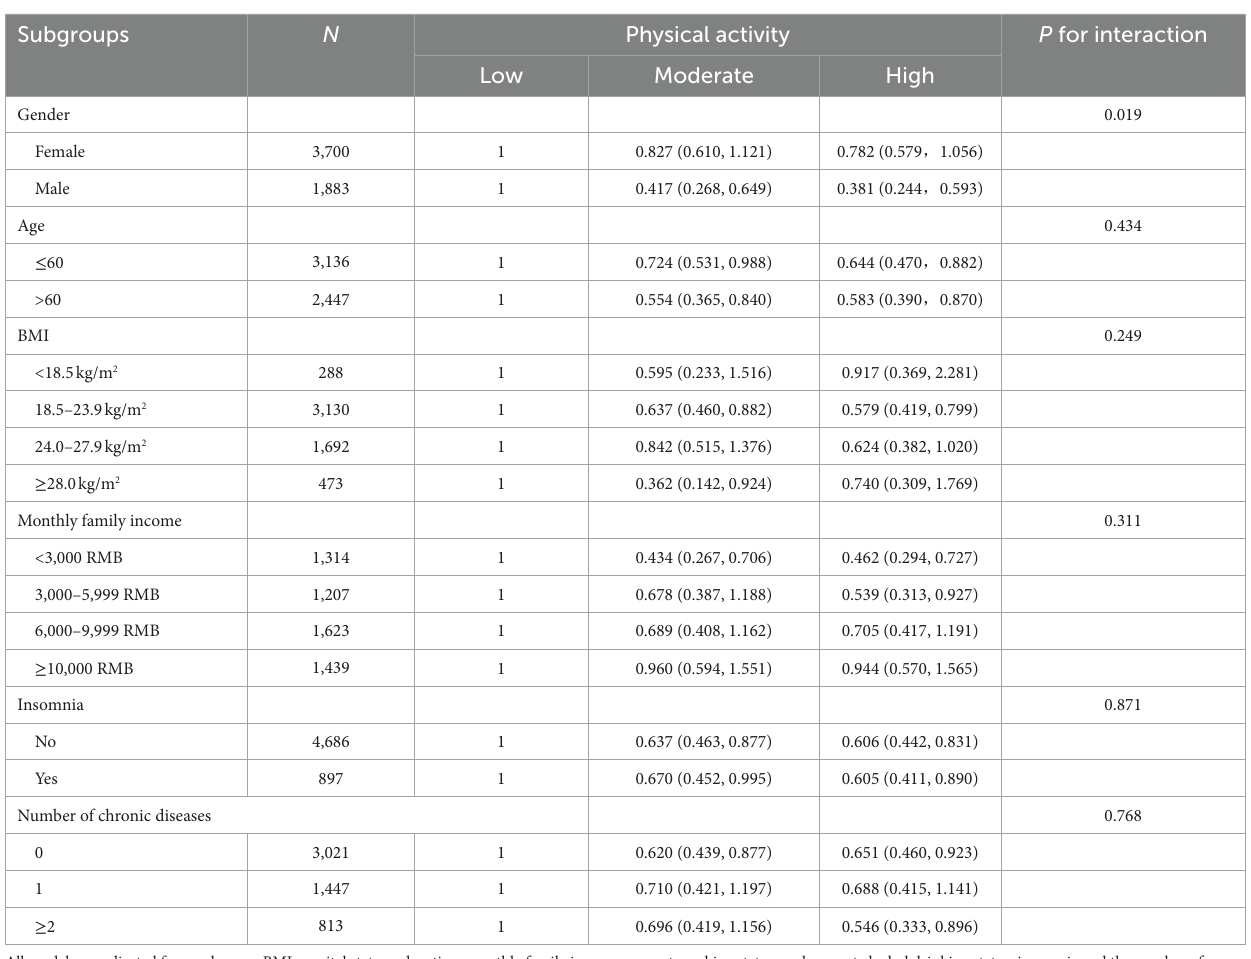
TABLE 3 Odd ratios for depression of physical activity levels by